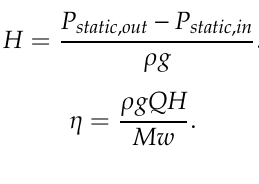
Table 2. Mesh independency.